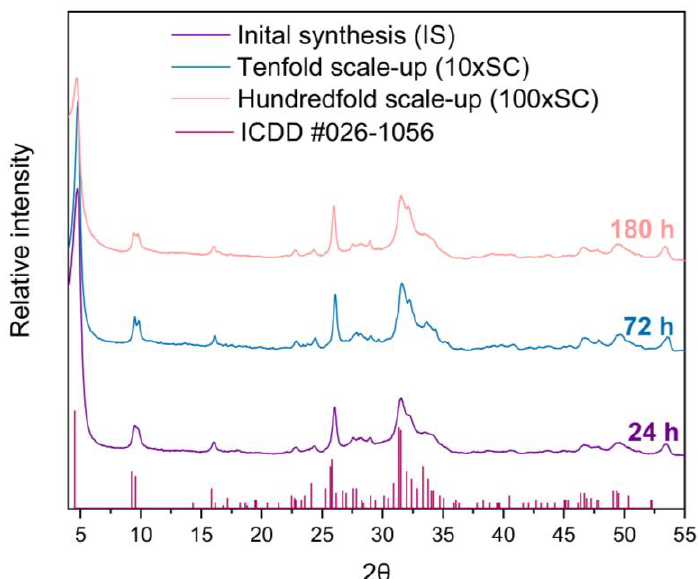
Figure 1. XRD patterns of final OCP powders obtained in three levels of scale-up. The reference simulated pattern (ICDD entry #026-1056) corresponds to the main maxima of the OCP triclinic phase.